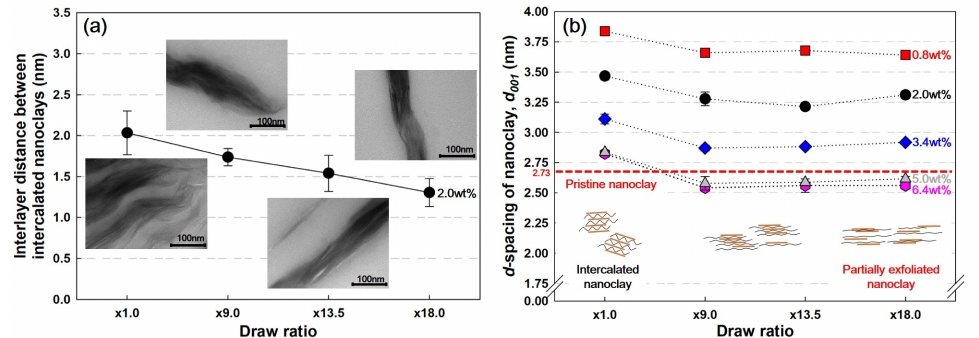
Figure 4. Nanoclay interlayer characteristics by ( a ) TEM and ( b ) XRD measurements (the number next to the plots in the graph is the content of nanoclay contained in the PP/nanoclay nanocomposite).